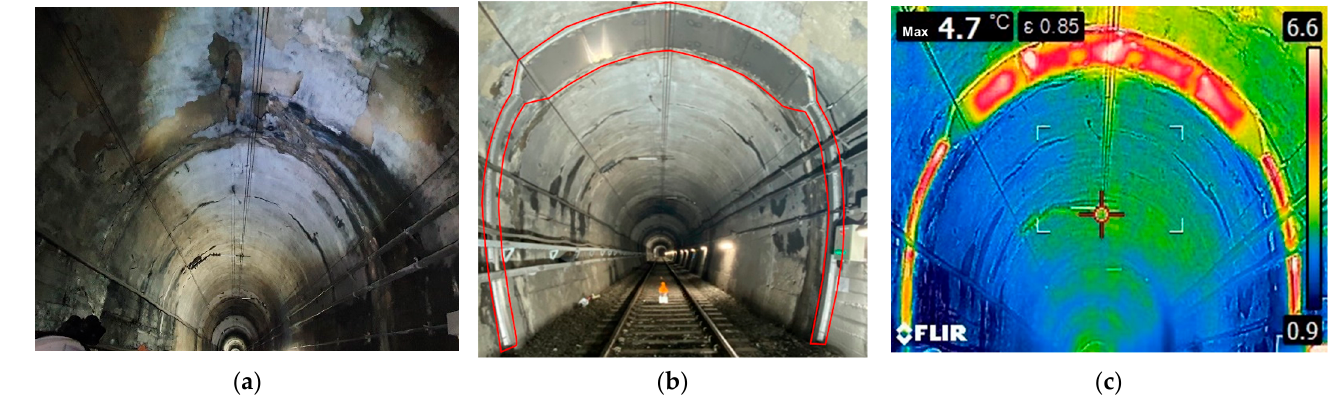
Figure 8. Installation of thawing-guided drainage system: ( a ) location of installation in Seungbu tunnel (location of crack); ( b ) system installation; ( c ) infrared image of operating system.